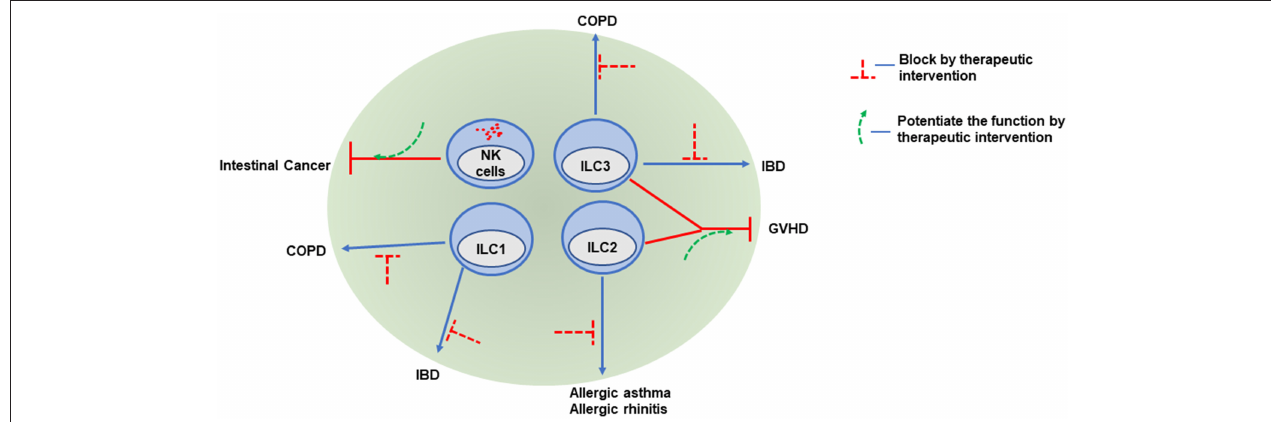
FIGURE 2 | ILCs as potential therapeutic targets. Because of their various roles in promoting or attenuating pathogenesis, ILCs may be potential therapeutic target. Infiltration of NK cells into intestinal cancer is associated with better prognosis, therefore increasing NK cell infiltration and potentiating NK cell functions in tumors might be beneficial. Hyperactivation of both ILC1 and ILC3 promote COPD and IBD. Regulation of pathogenic cytokine production or antibody mediated depletion of these cells might be a potential treatment option. Similarly, antibodies targeting type-2 cytokines produced by ILC2 may be promising in the treatment of allergy and asthma patients. Both ILC2 and ILC3 ameliorate clinical symptoms and play protective roles in GVHD. Expansion of ILC2 and ILC3 numbers by therapeutic intervention might be helpful to control GVHD.